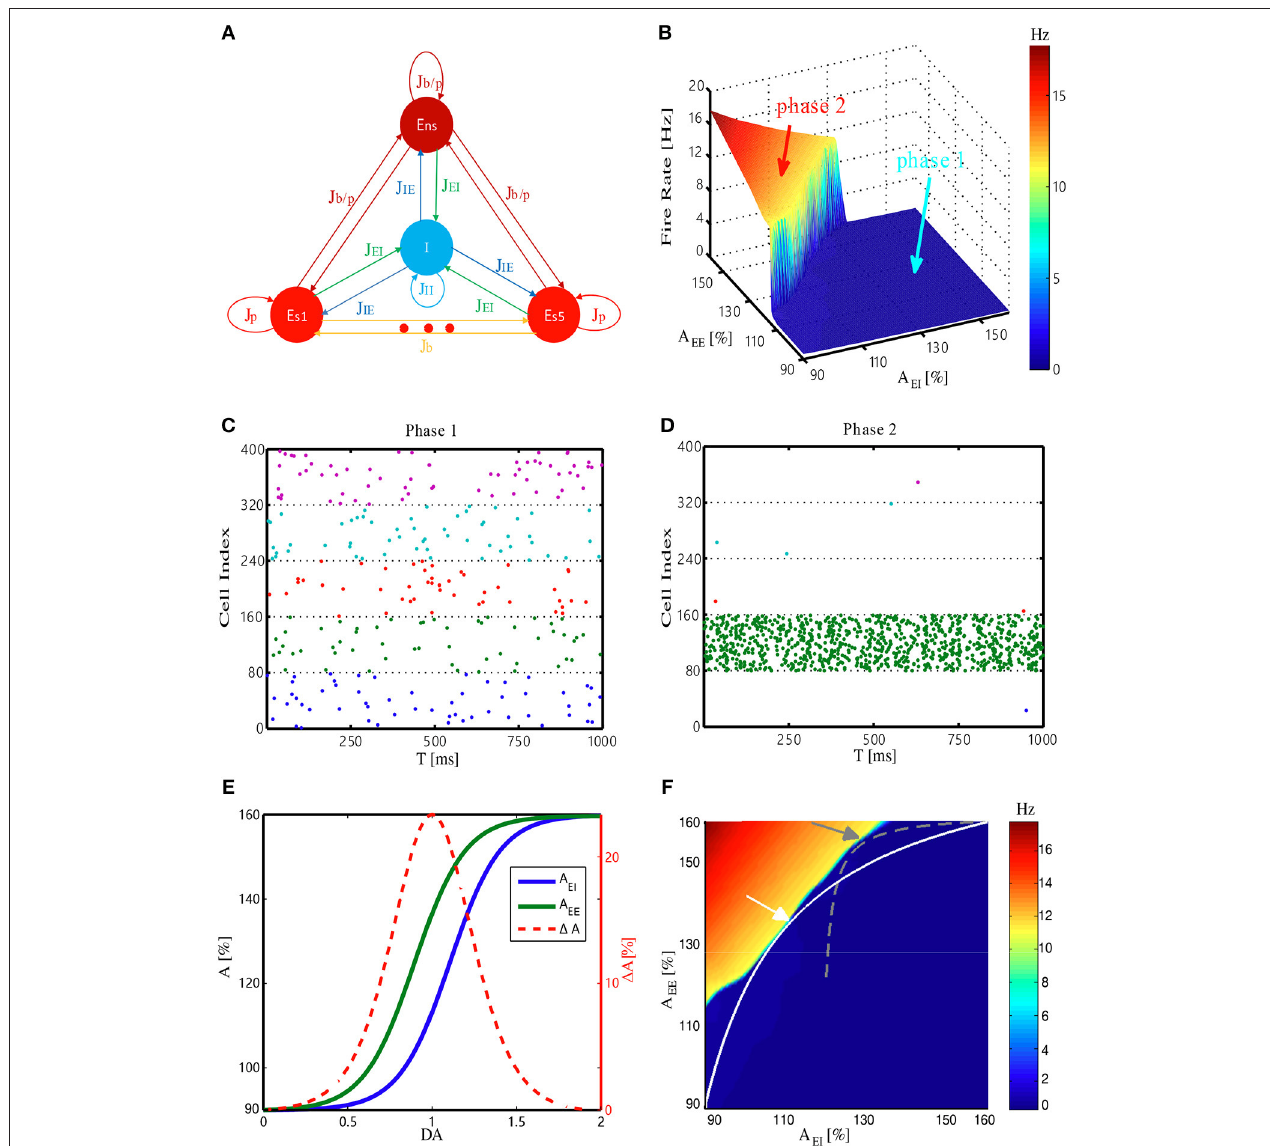
FIGURE 1 | Structure and dynamic behavior of the WM model, and its DA modulation. (A) Network architecture. E S1 , …, E S5 , E ns and I denote five selective excitatory populations, one non-selective excitatory population, and one inhibitory population, respectively. J ij (where i , j is I or E) denotes the synaptic connection from i population to j population. The E–E synapse can be a potentiated value ( J p ), baseline value ( J b ), or potentiated value with a certain probability ( J b / p ). J EI and J EE ( J b , J p , J b / p ) are modulated by DA (see Materials and Methods). (B) Firing rate of the most active Es population at rest (i.e., without external stimulus) changes with synaptic strength among excitatory neurons ( J EE ) and from the excitatory to inhibitory neurons ( J EI ). A EE and A EI are the scaling factors for J EE and J EI , respectively. (C,D) Spiking patterns corresponding to the two different phases ( phase1 and phase2 ) in (B) . Different colors represent five Es populations (only 10% neurons are shown), with each dot denoting a spike. (E) Scaling factors A EE and A EI change as a function of dopamine D1 activation level. The strength difference A EE A EI ) reaches its maximum at DA ( 1 A 1.0. (F) Trajectories represent how the corresponding system state changes with DA. The system represented by the = − = white trajectory is analyzed in the main text. Similar results can also be obtained through the gray trajectory (with a different synaptic strength range), demonstrating the robustness of the results. Arrows mark the intermediate level of DA 1.0. =